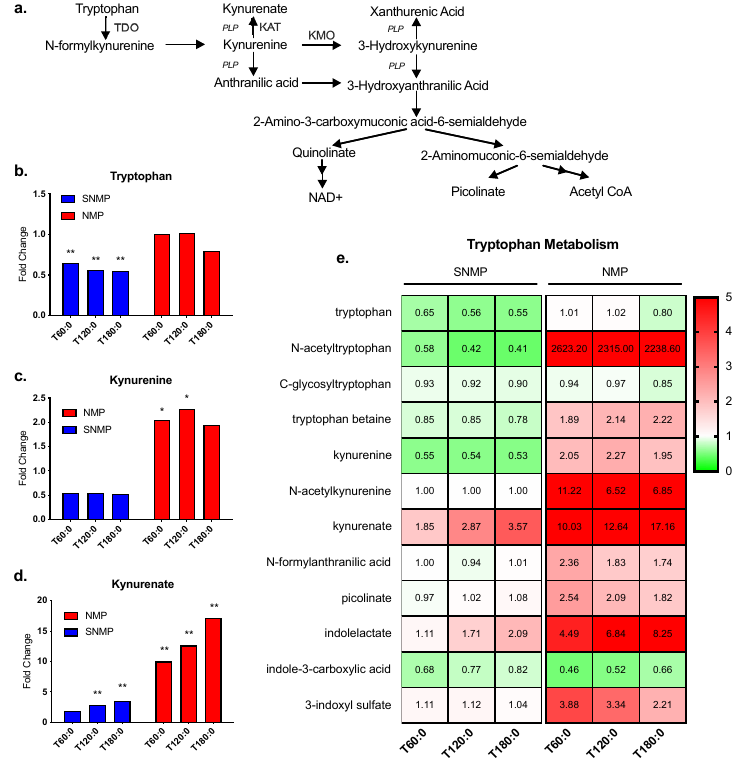
Figure 4. Tryptophan metabolism via the kynurenine pathway during SNMP vs. NMP. ( a ) Tryptophan metabolism via the kynurenine pathway. PLP is a necessary cofactor for several steps in the pathway. ( b ) SNMP livers demonstrate a significant decrease in liver tryptophan concentrations compared to NMP livers. However, NMP livers demonstrate a significant increase in tissue ( c ) kynurenine and ( d ) kynurenate compared to the SNMP group. ( e ) Heatmap of metabolites involved in tryptophan metabolites analyzed in the untargeted metabolomic analysis. ** indicates p ≤ 0.05 and * indicates 0.05 < p < 0.10. Abbreviations: TDO, tryptophan 2,3-dioxygenase; KAT, kynurenine aminotransferase; KMO, kynurenine 3-monooxygenase; PLP, pyridoxal 5-phosphate, NAD + , nicotinamide adenine nucleotide; SNMP, subnormothermic machine perfusion; NMP, normothermic machine perfusion; x-axis represents fold change at 60, 120, and 180 min compared to pre-perfusion